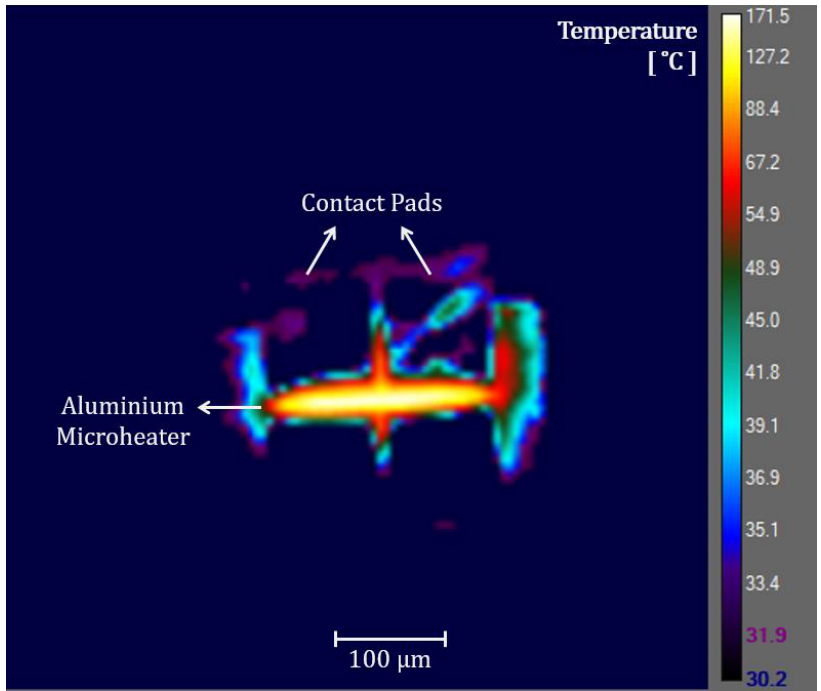
Figure 10. Thermal micrograph of an aluminum microheater on a CMOS chip.